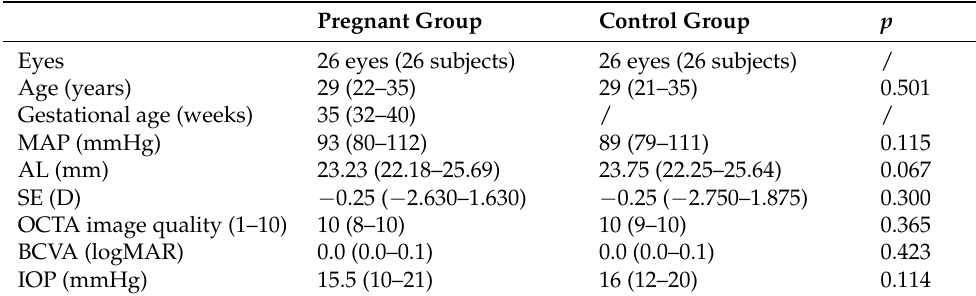
Table 1. Demographic and clinical data.